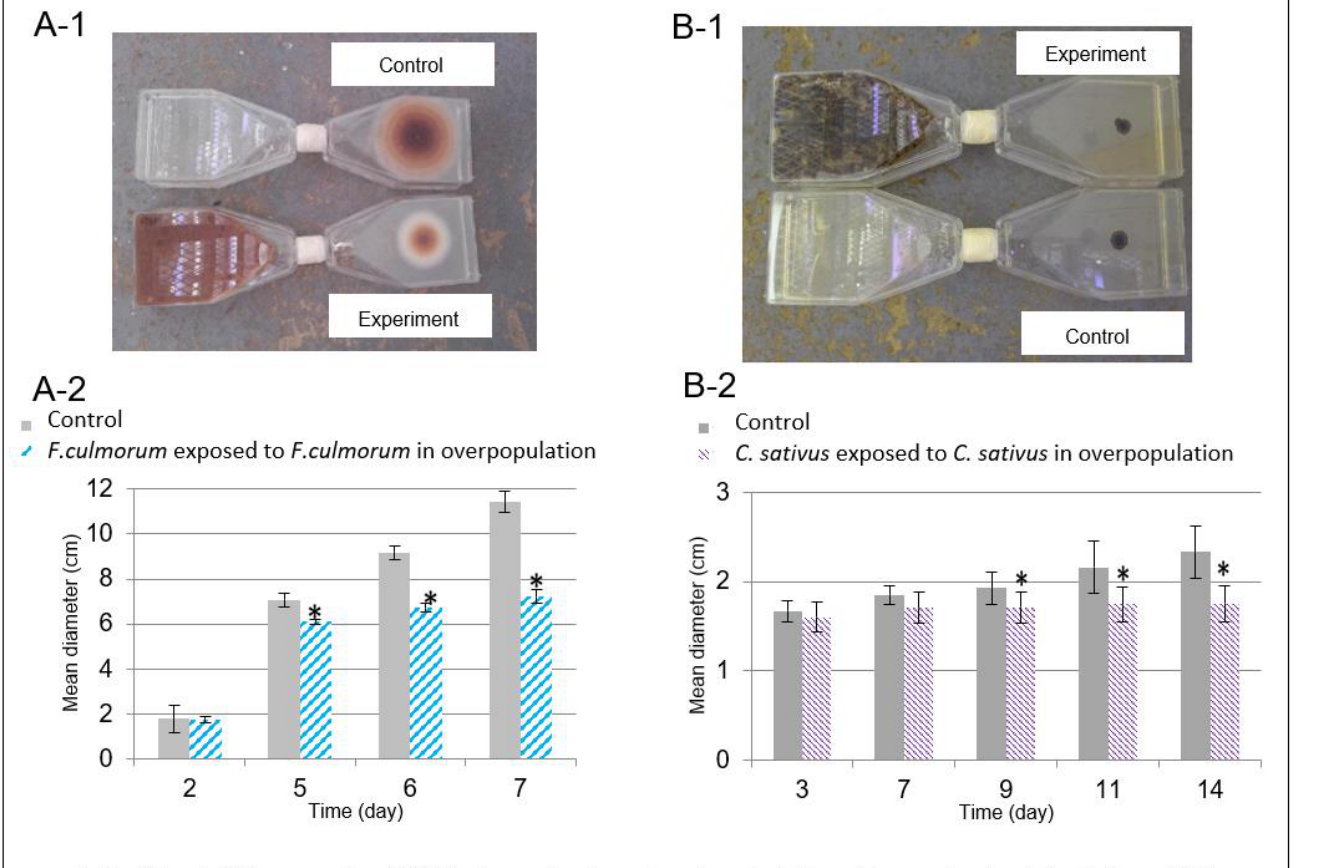
Figure 6 . Pictures and effects of F. culmorum and C. sativus volatolomes under overpopulation conditions towards F.culmorum ( A ) or the C. sativus ( B ) growth in normal condition .